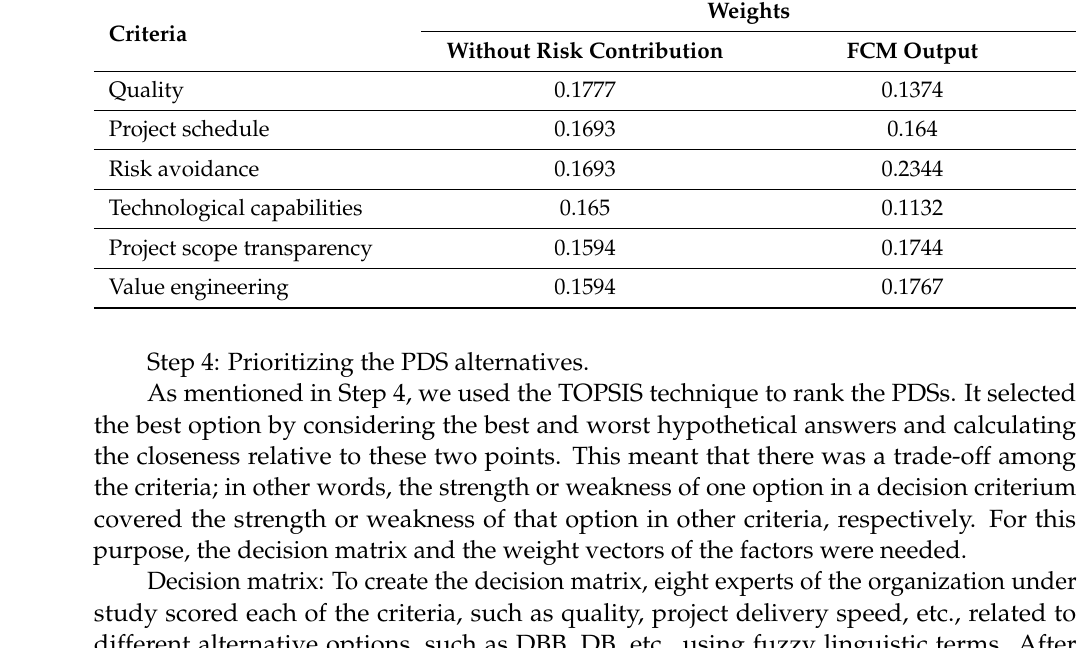
Table 8. Weights of PDSs’ selection criteria—with and without risk contribution.